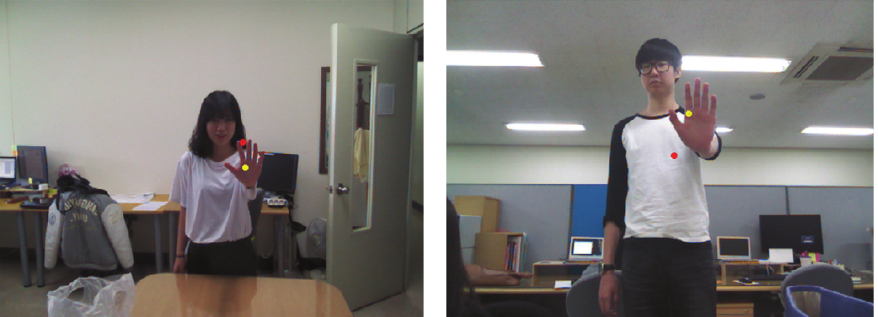
Figure 2: Examples of shoulder point detection errors caused by the self-occlusion problem (red dot: shoulder point, yellow dot: hand point).